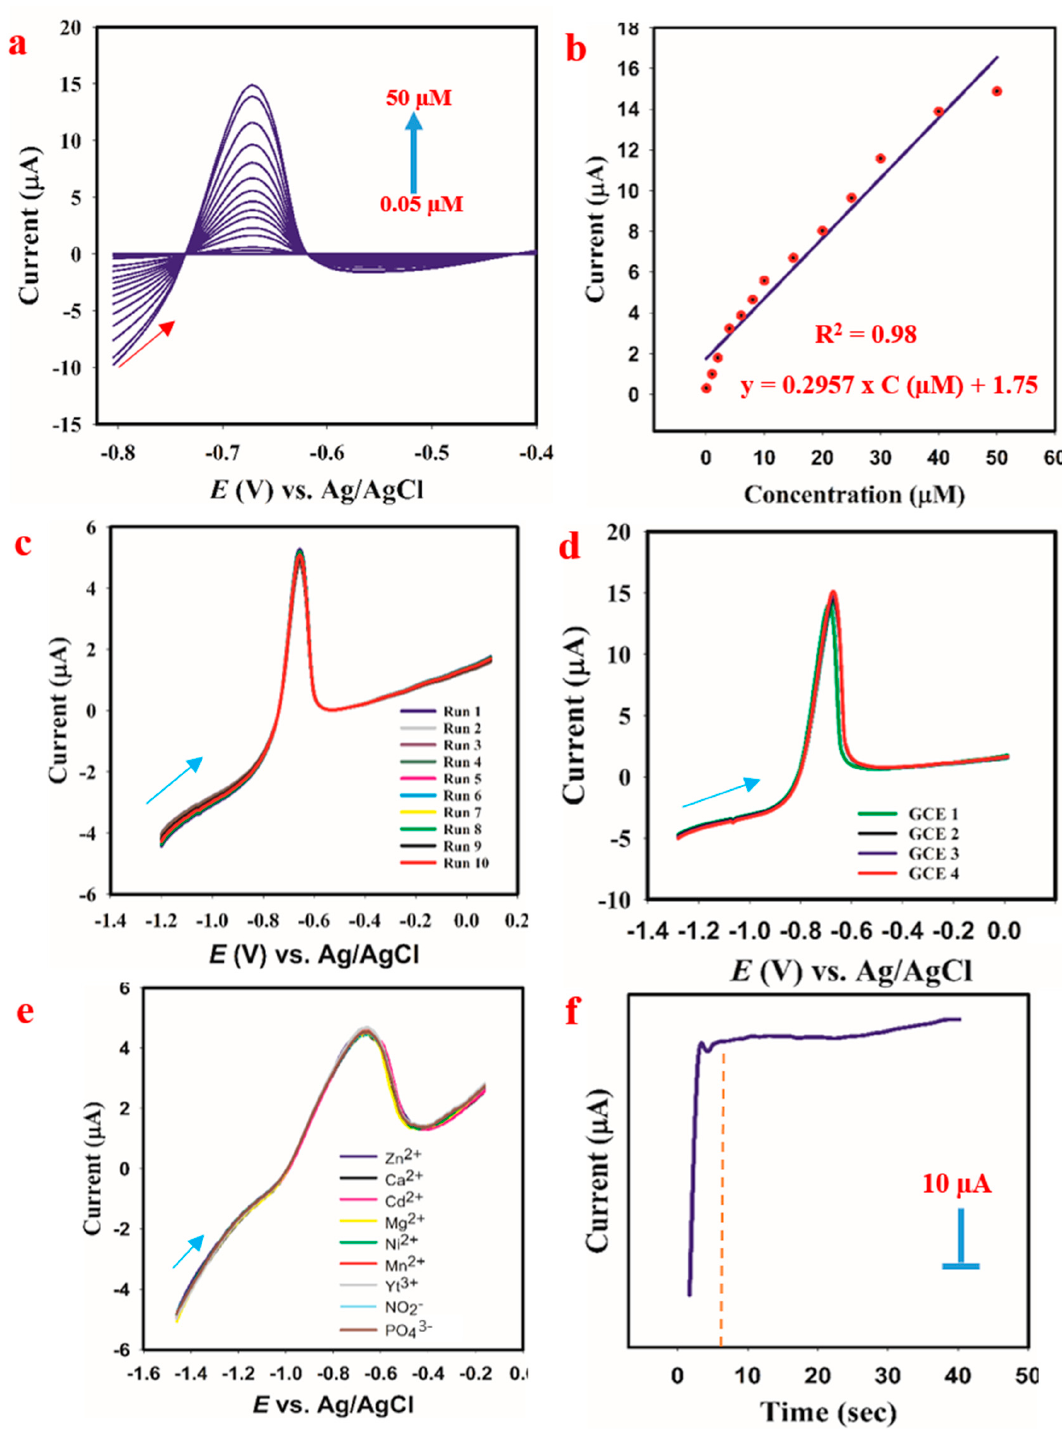
Figure 6. ( a ) Effect of varying the Cd 2+ ion concentration. ( b ) Linear plot of current response against Cd 2+ concentration. ( c ) Repeatability test. ( d ) Reproducibility test. ( e ) The effect of interferents on current response. ( f ) The recorded response time.